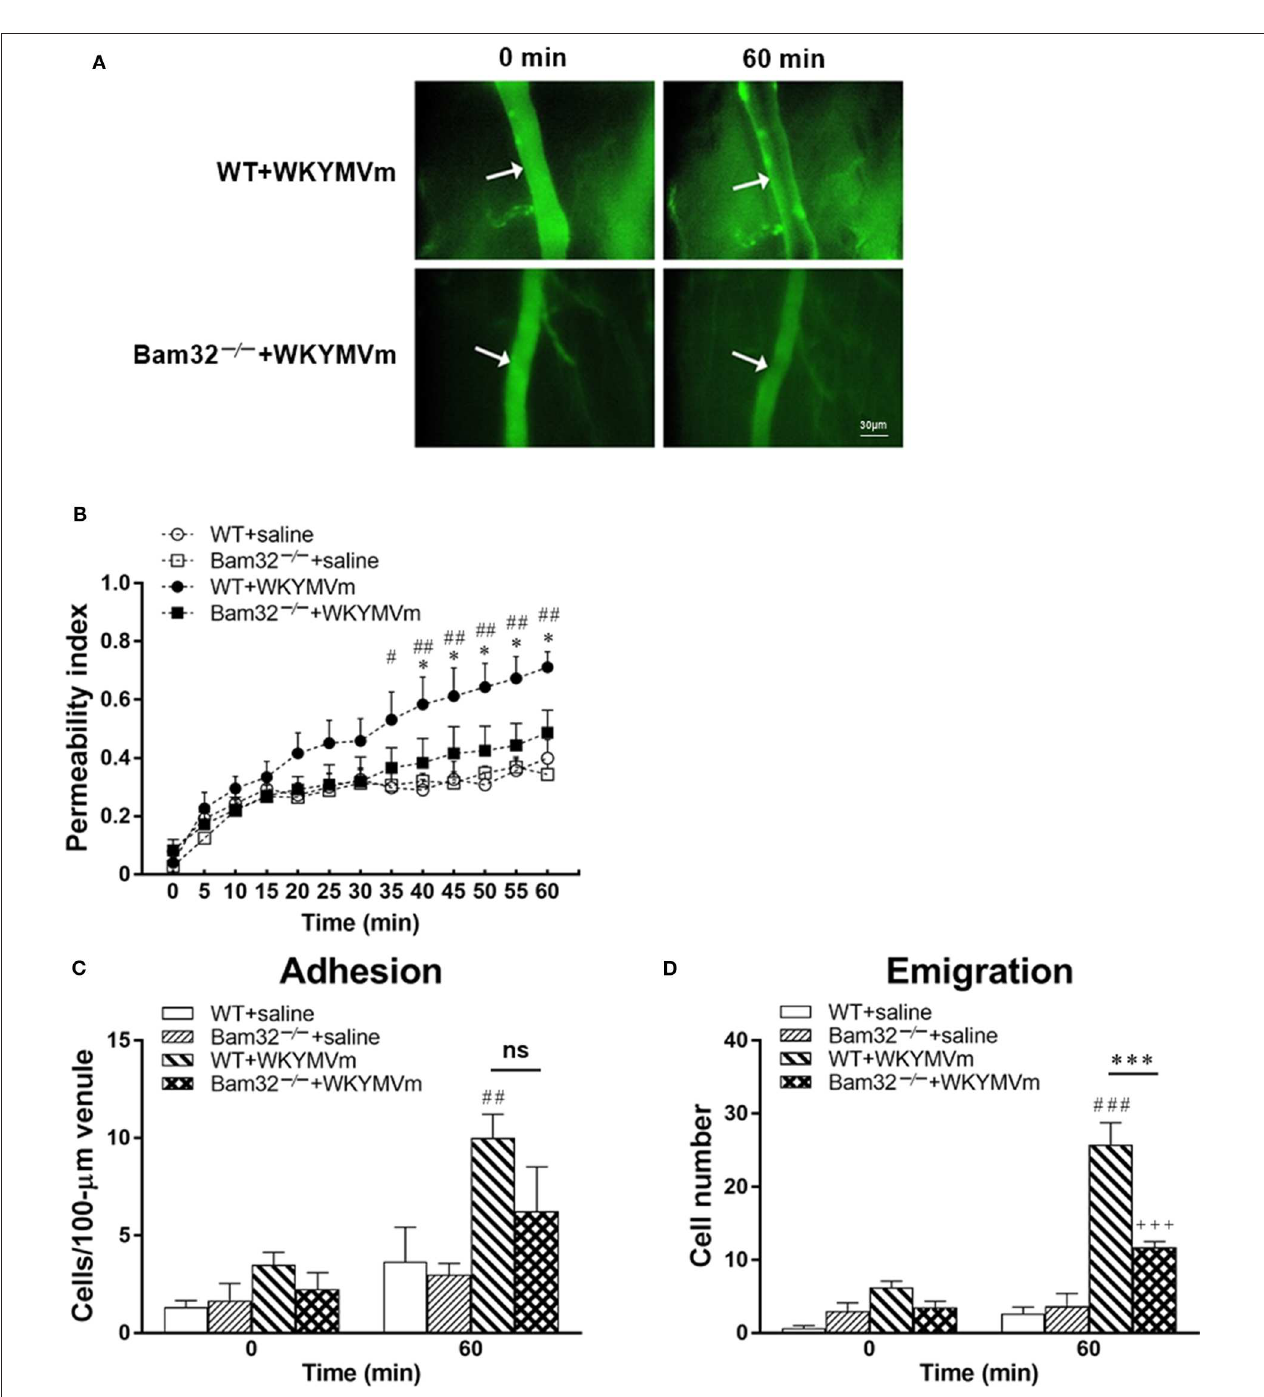
FIGURE 1 | WKYMVm-induced microvascular hyperpermeability in WT and Bam32 − / − mice. (A) Representative fluorescence micrographs of hyperpermeability in mouse cremasteric post-capillary venules before (0min) and 60min after superfusion with WKYMVm in WT (upper panel) and Bam32 − / − (lower panel) mice. Arrow in micrograph indicates the venular segment for permeability index measurements (Magnification: 200 × ). (B) Permeability indices of mouse cremasteric post-capillary venules following 60-min superfusion with bicarbonate-buffered saline (white symbols) or WKYMVm (0.1 µ M, black symbols) in WT and Bam32 − / − mice. Neutrophil adhesion number on 100- µ m length of venule (C) and neutrophil emigration number ( D , cells/443 × 286 µ m 2 field) were determined simultaneously in the same experiments of WKYMVm-induced cremasteric microvascular hyperpermeability before (0min) and 60min following superfusion with WKYMVm. (B–D) mean ± SEM, n = 4. Significant differences between WT and Bam32 − / − mice (* p < 0.05 and *** p < 0.001). Significant differences between WT mice with and without WKYMVm treatment ( # p < 0.05, ## p < 0.01, and ### p < 0.001). Significant difference between Bam32 − / − mice with and without WKYMVm treatment ( +++ p < 0.001). ns, not